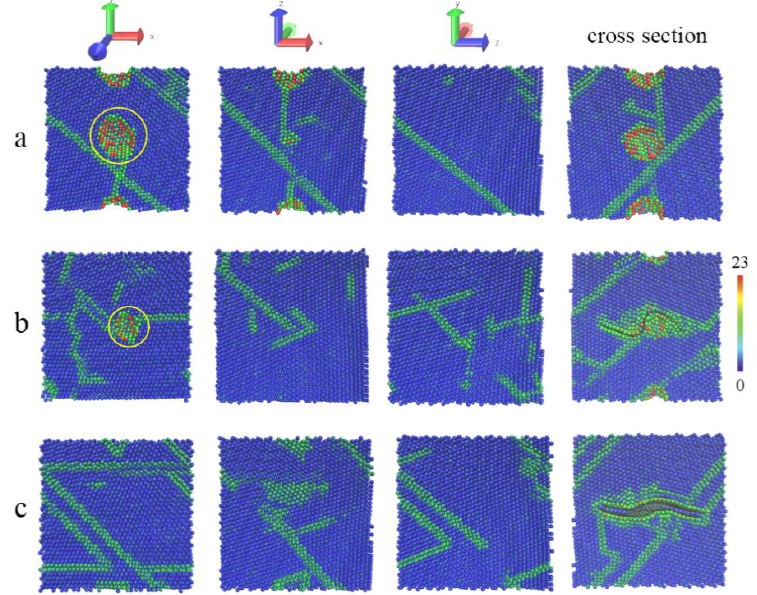
Figure 3. The atomic configures of sintered models in different views. ( a ) The pure Al structure, ( b ) the structure of the composite with SLG, ( c ) and the structure of the composite with BLG.